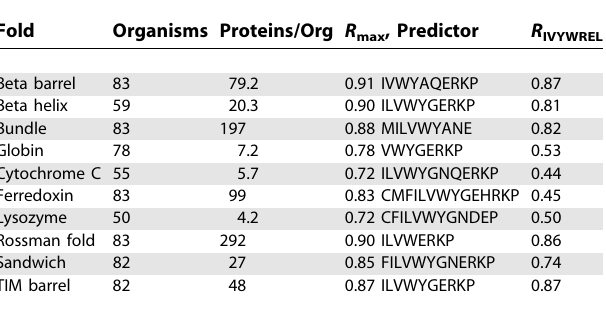
Table 2. Thermostability Predictors for the Major Protein Folds Fold Organisms Proteins/Org R max ,